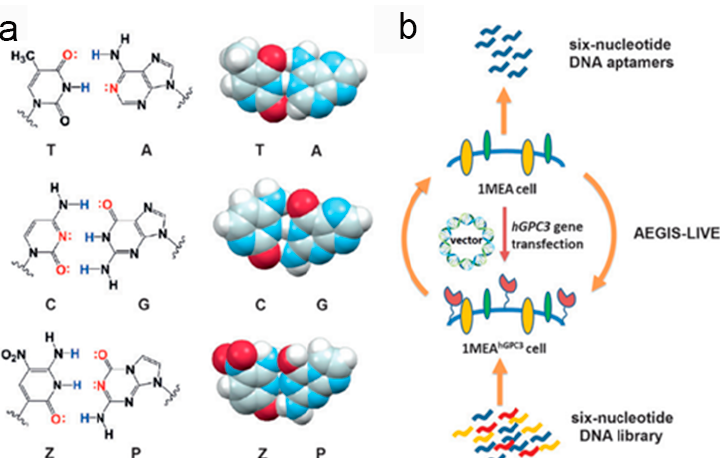
Figure 15. Schematic illustration of hybridization of the six nucleotides for an artificially expanded genetic information system (AEGIS) in Laboratory In Vitro Evolution (LIVE). ( a ) Molecular structures and space-filling models of C:G, T:A, and Z:P pairs showing their similarity; ( b ) Application of the artificial aptamers in biomarker discovery based on the AEGIS-LIVE selection procedure. Reprinted with permission from © (2016) WILEY-VCH Verlag GmbH & Co. KGaA [96].